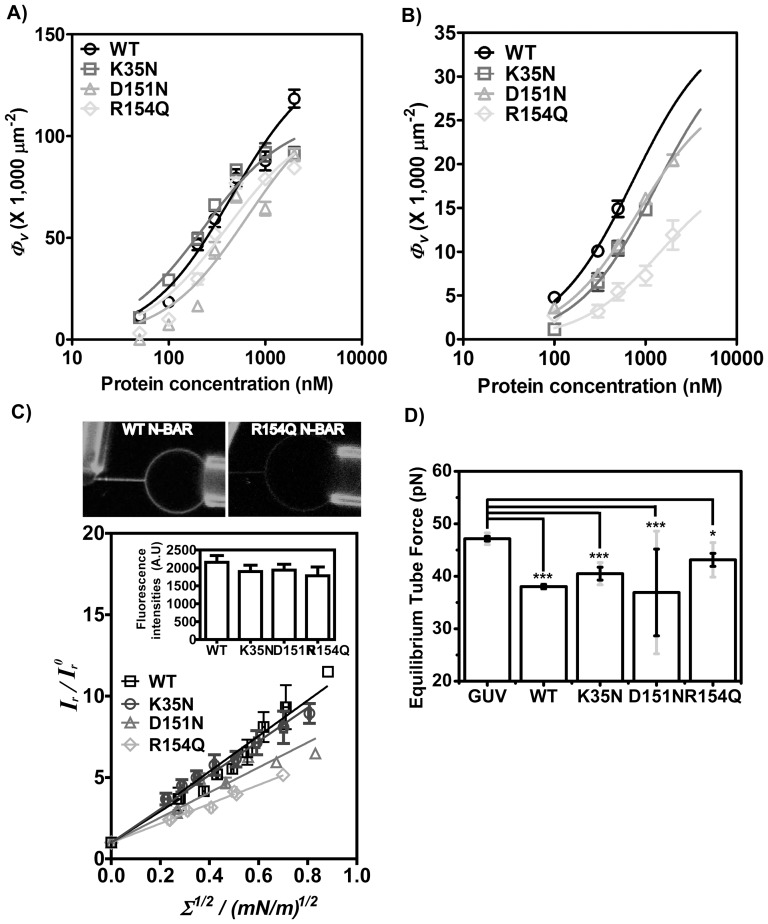
R154Q mutation lowers membrane association density.Protein adsorption isotherm on GUVs composed of A) 100% DOPS and B) 60% DOPC, 20% DOPS, 10% DOPE, and 10% PI(4,5)P2. Protein and vesicles are incubated in 20 mM Hepes, 50 mM NaCl, 1 mM DTT, pH 7.4 buffer at room temperature for 30 minutes before imaging on confocal fluorescence microscopy. Green fluorescence intensities on vesicle equators are measured and normalized to the total membrane area. Absolute molecule density is calculated according to the calibration curve. Data are fitted by the Langmuir isotherm model to obtain Kd and Bmax. Membrane bound density of R154Q dramatically decreases on biomimetic membrane. The error bars are the standard error of the mean of 10 measured GUVs. C) Quantitative analysis of the curvature sorting abilities of BIN1 N-BAR domain and its mutants. A membrane tether is pulled from a micropipette-aspirated GUV (60% DOPC, 20% DOPS, 10% DOPE, 10% PI(4,5)P2, labeled by Texas-Red lipid dye) by a polystyrene bead and imaged by confocal fluorescence microscopy. At 100 nM, WT N-BAR fluorescence on GUV and tether is brighter than R154Q N-BAR as shown in the upper panel. WT (100 nM), K35N (100 nM), D151N (100 nM) and R154Q (600 nM) are pre-incubated with GUVs in 20 mM Hepes, 50 mM NaCl, 1 mM DTT, pH 7.4 buffer at room temperature for 30 minutes before transfer to aspiration chamber. By increasing membrane tension controlled by aspiration pressure, protein partitioning on tubular membrane tether and decrease in lipid fluorescence on tether is observed. Curvature coupling parameter
/
 from images recorded by Kalman-averaged confocal xz line-scan images is plotted with square root of membrane tension, revealing a linear relationship. Data from six vesicles was binned (vertical error bars represent standard error of the mean of
/
 and horizontal error bars show standard error of the mean of square root of tension). Inset graph demonstrates similar fluorescence intensity on GUVs analyzed for four BIN1 variants. Error bars are standard errors of the mean. D) Equilibrium force of tethers (pulled from GUVs with composition (60% DOPC, 20% DOPS, 10% DOPE, 10% PI(4,5)P2) measured by optical trap at membrane tension of 0.21±0.003 mN/m. Error bars: standard error of the mean in black and standard deviation in light grey. Student t-test for statistical significance: n.s: p>0.05, *: p<0.05, **: p<0.01, ***: p<0.001.